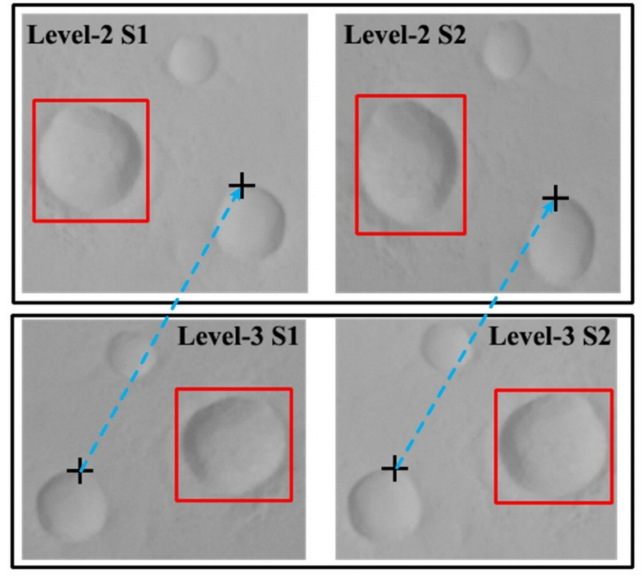
Figure 6. Stereo pair comparison between the HRSC Level-2 and Level-3